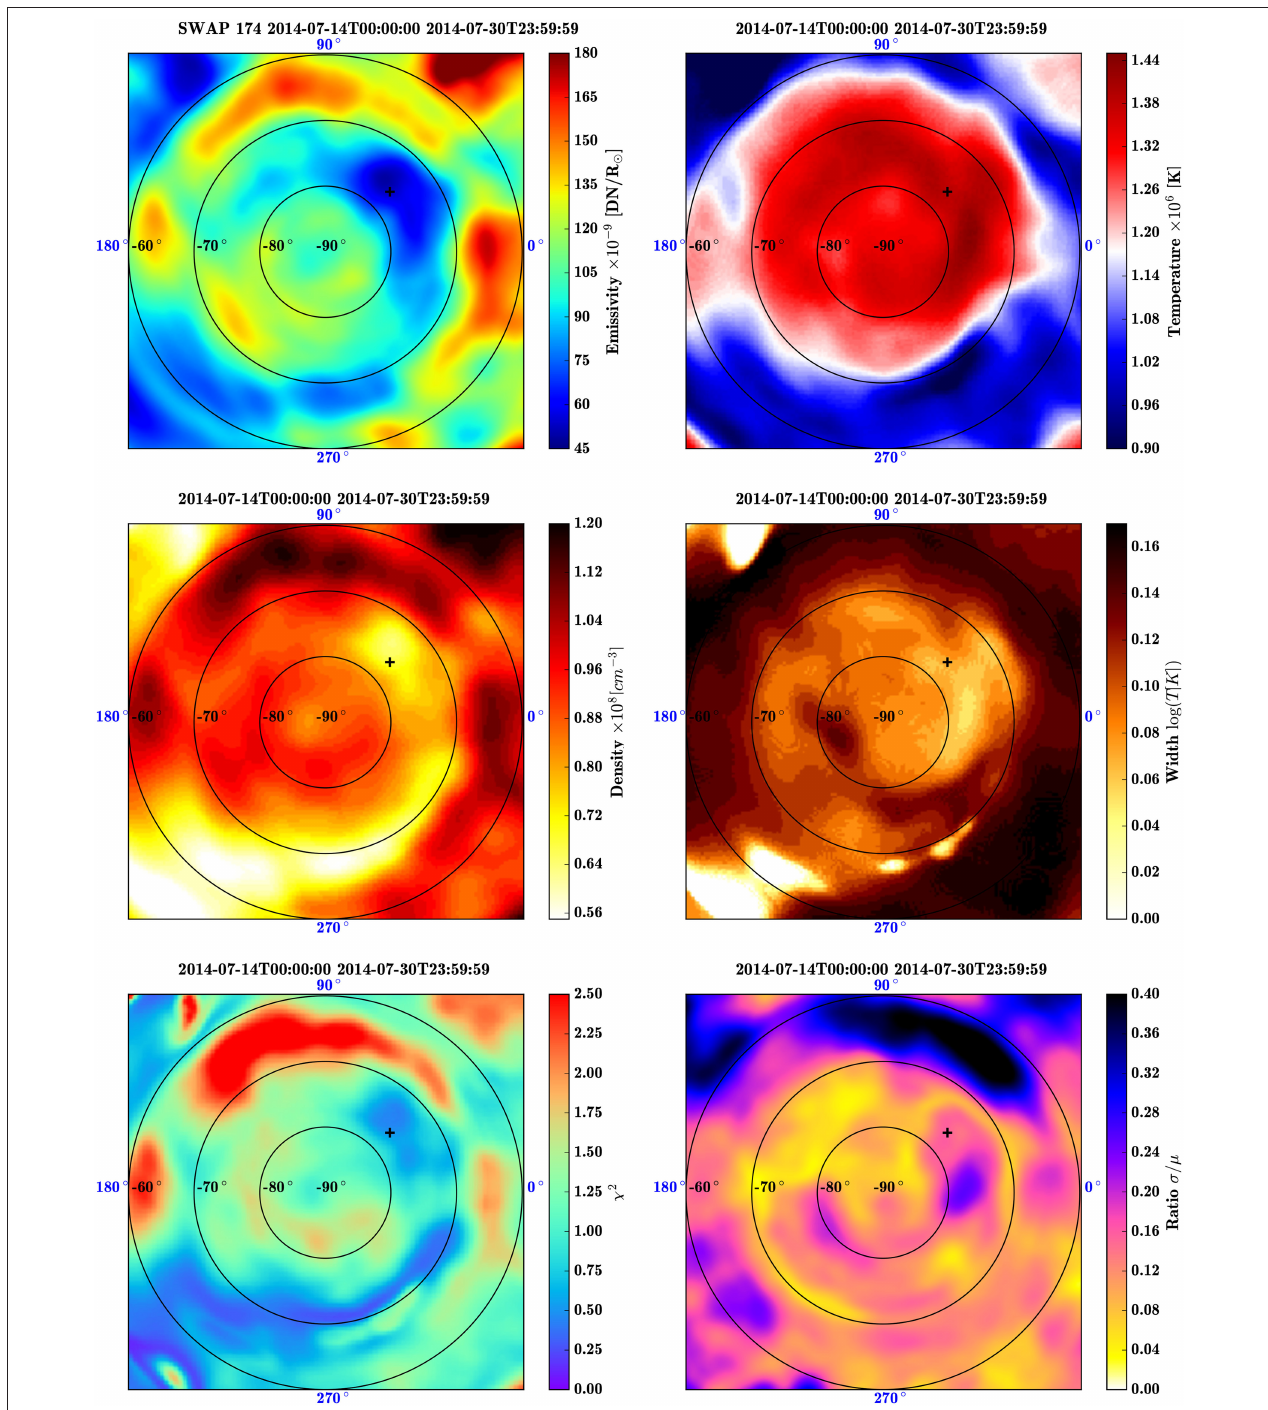
FIGURE 7 | Example of full tomography/Gaussian DEM coupling analysis at 1.05 R ⊙ corresponding to the AIA polar view presented in Figure 6. The black plus sign is the cavity position measured in the SWAP cubes at 1.05 R . Top left: Corresponding SWAP polar view. Top right: Temperature [K], i.e., the central ⊙ temperature T c of the assumed Gaussian local DEMs. Middle left: Density, in units of cm − 3 . Middle right: Thermal width, i.e., the Gaussian width of the assumed Gaussian DEM. Bottom left: Residual χ 2 of the Gaussian DEM inversion. Bottom right: Standard deviation of the 17 consecutive emissivity cubes computed using a 1-day time-sliding window, giving an indication of the temporal evolution of the system.